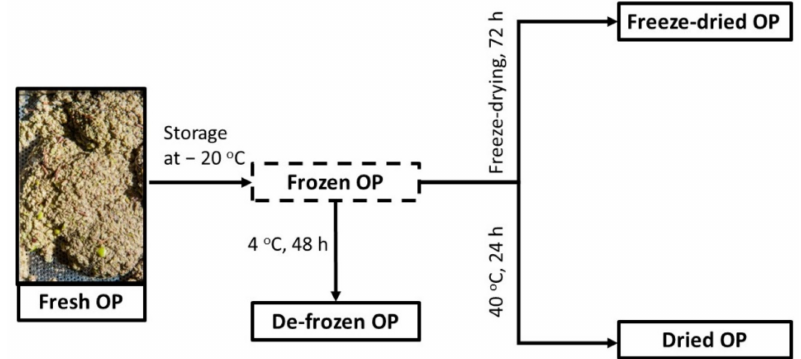
Figure 4. Four different storage conditions of the olive pomace